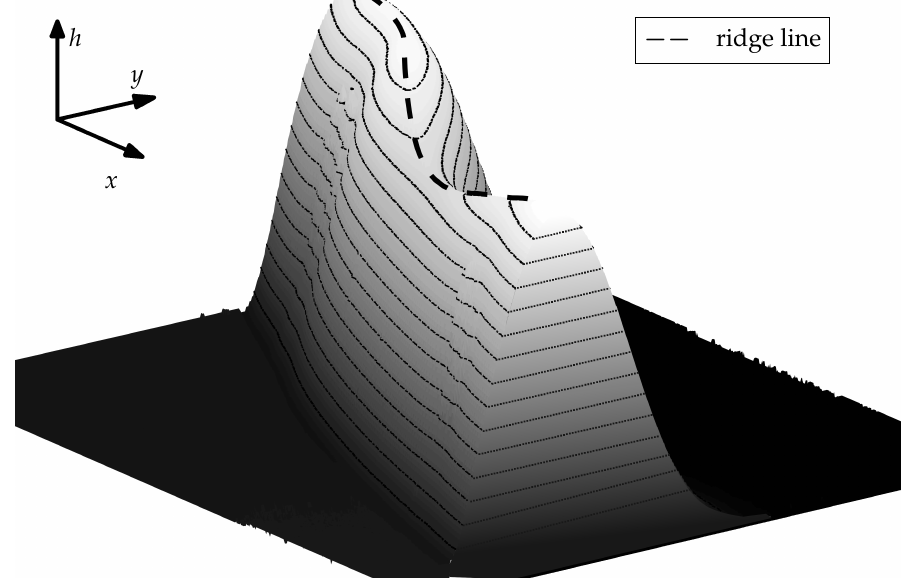
Figure 10. Illustration of the term ridge line used within this work. The figure shows a portion of a pertubed ridge as depicted in Figure 8. Image obtained with a PS of 335kgmol − 1